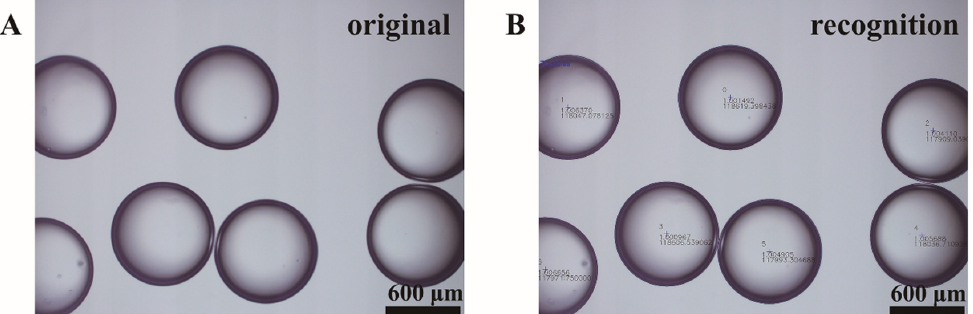
Figure 2. ( A ) The original image of droplets. ( B ) The image after program recognition. The larger the value of MP , the better the mixing performance.